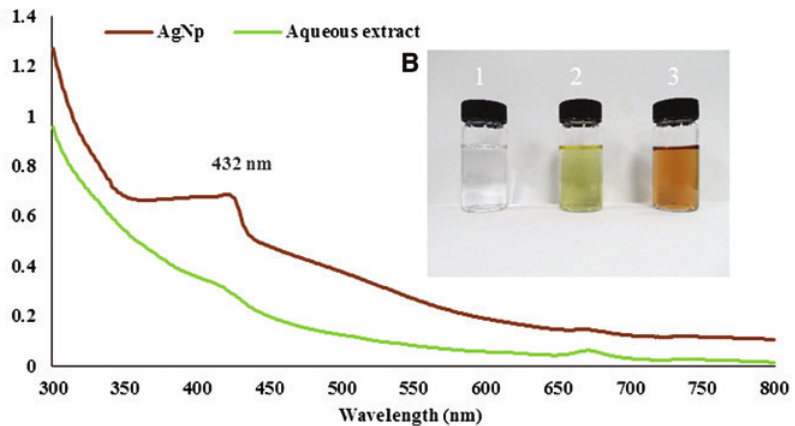
Figure 3: (A) UV-visible spectrum of optimized AgNPs (1 mm AgNO Saccharina japonica (DSP) and aqueous solution of AgNO